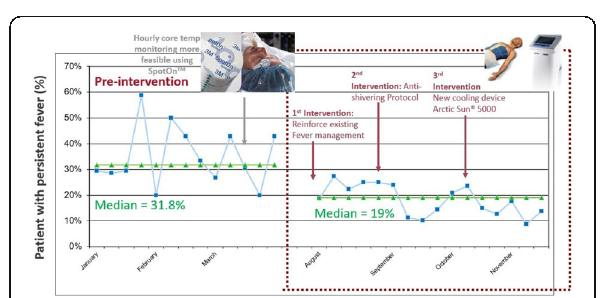
Fig. 3 (abstract 000598). See text for